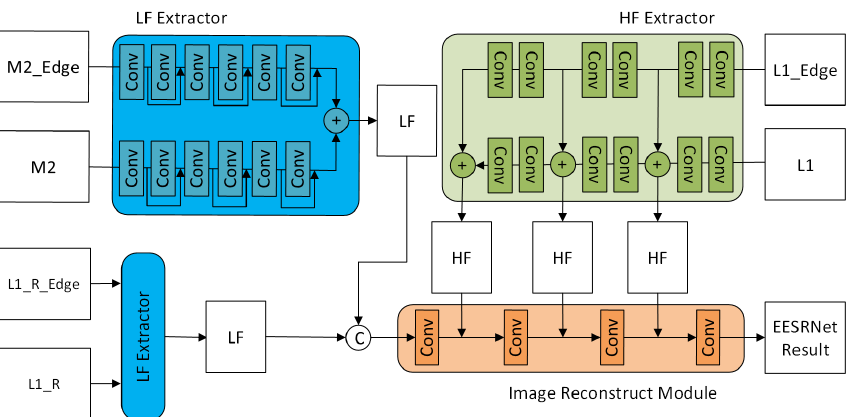
Figure 3. Architecture of the EESRNet. M 2 _ Edge , L 1 _ Edge , and L 1 _ R _ Edge refer to the edge map derived from the corresponding image, respectively. LF and HF refer to low-resolution features and high-resolution features,